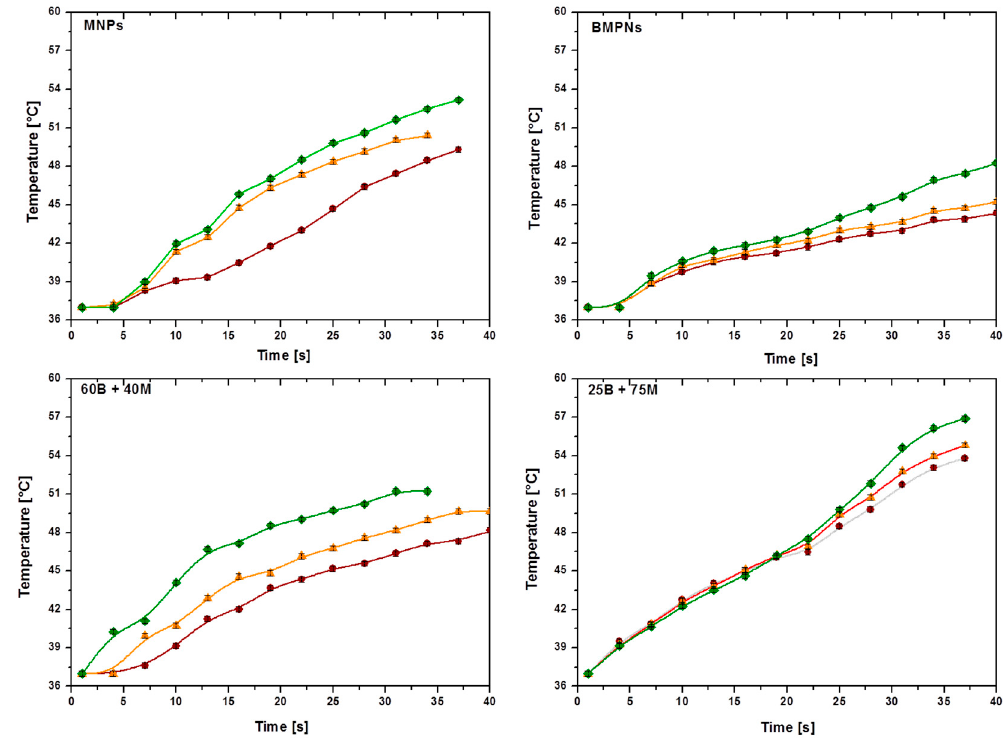
Figure 7. Time evolution of the temperature of the MNP suspensions, for different frequencies: 197 kHz ( ● ), 236 kHz ( ▲ ), and 280 kHz ( ♦ ). Field strength: H 0 = 18 kA/m. Sample volume 0.5 mL; particle concentration: 25 mg/mL.